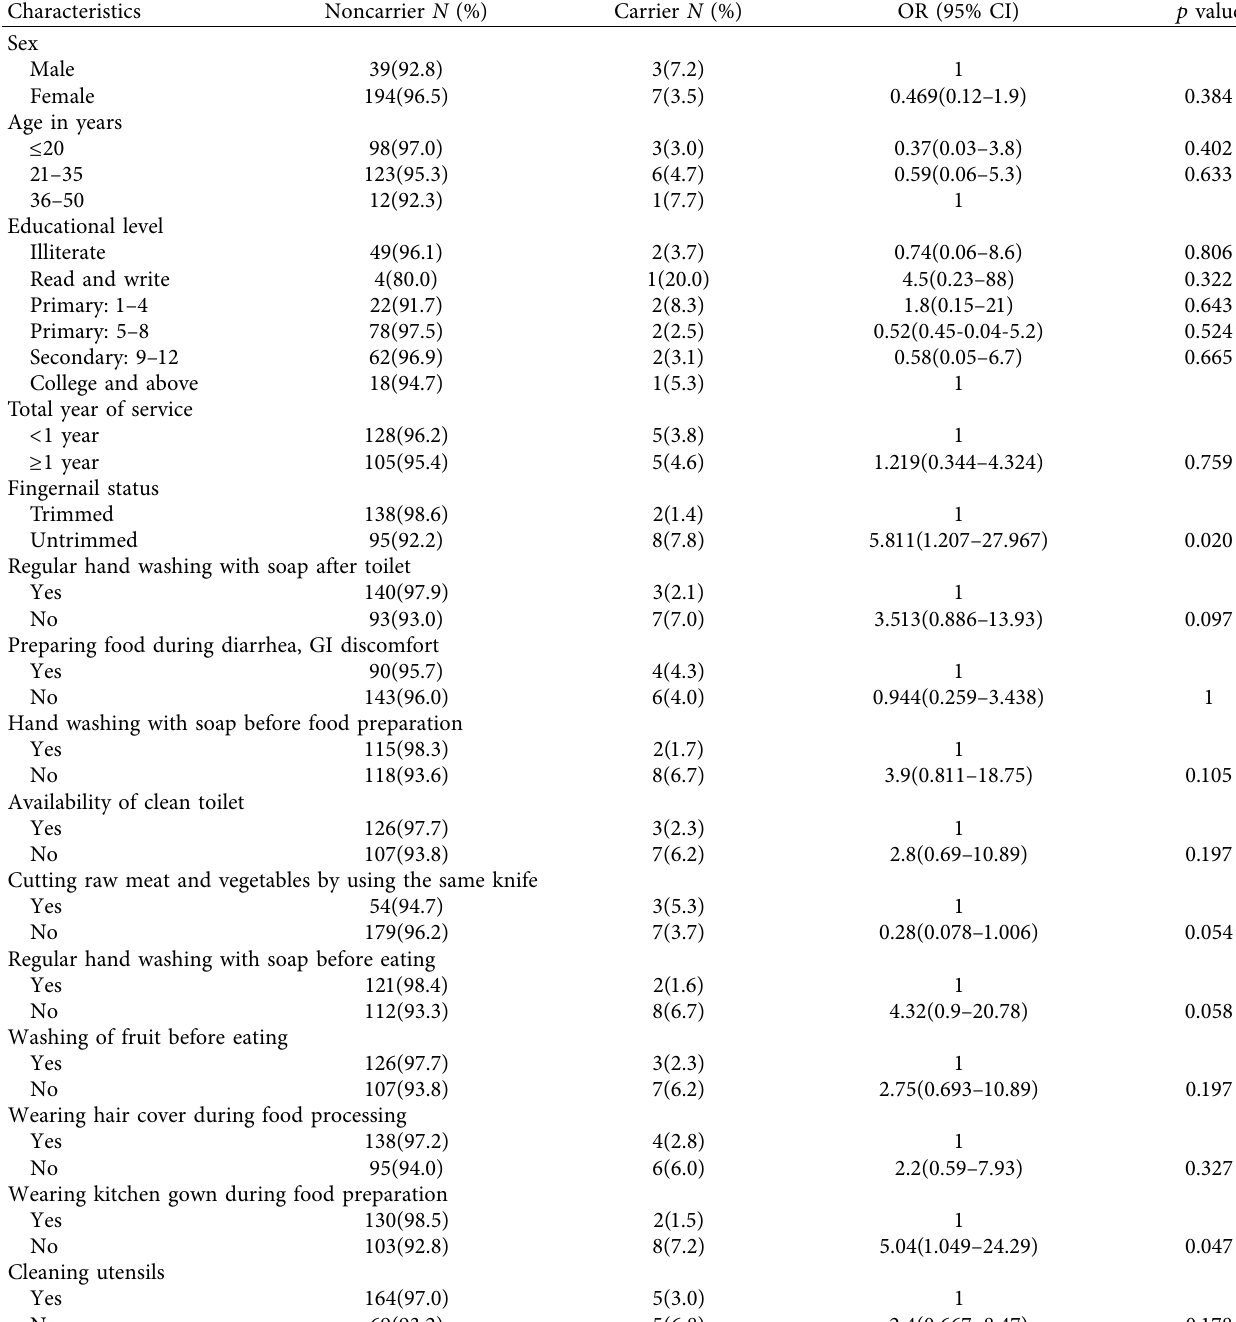
Table 2: Bivariate analysis of risk factors associated with Salmonella and Shigella isolates in food handlers in Motta town, North West